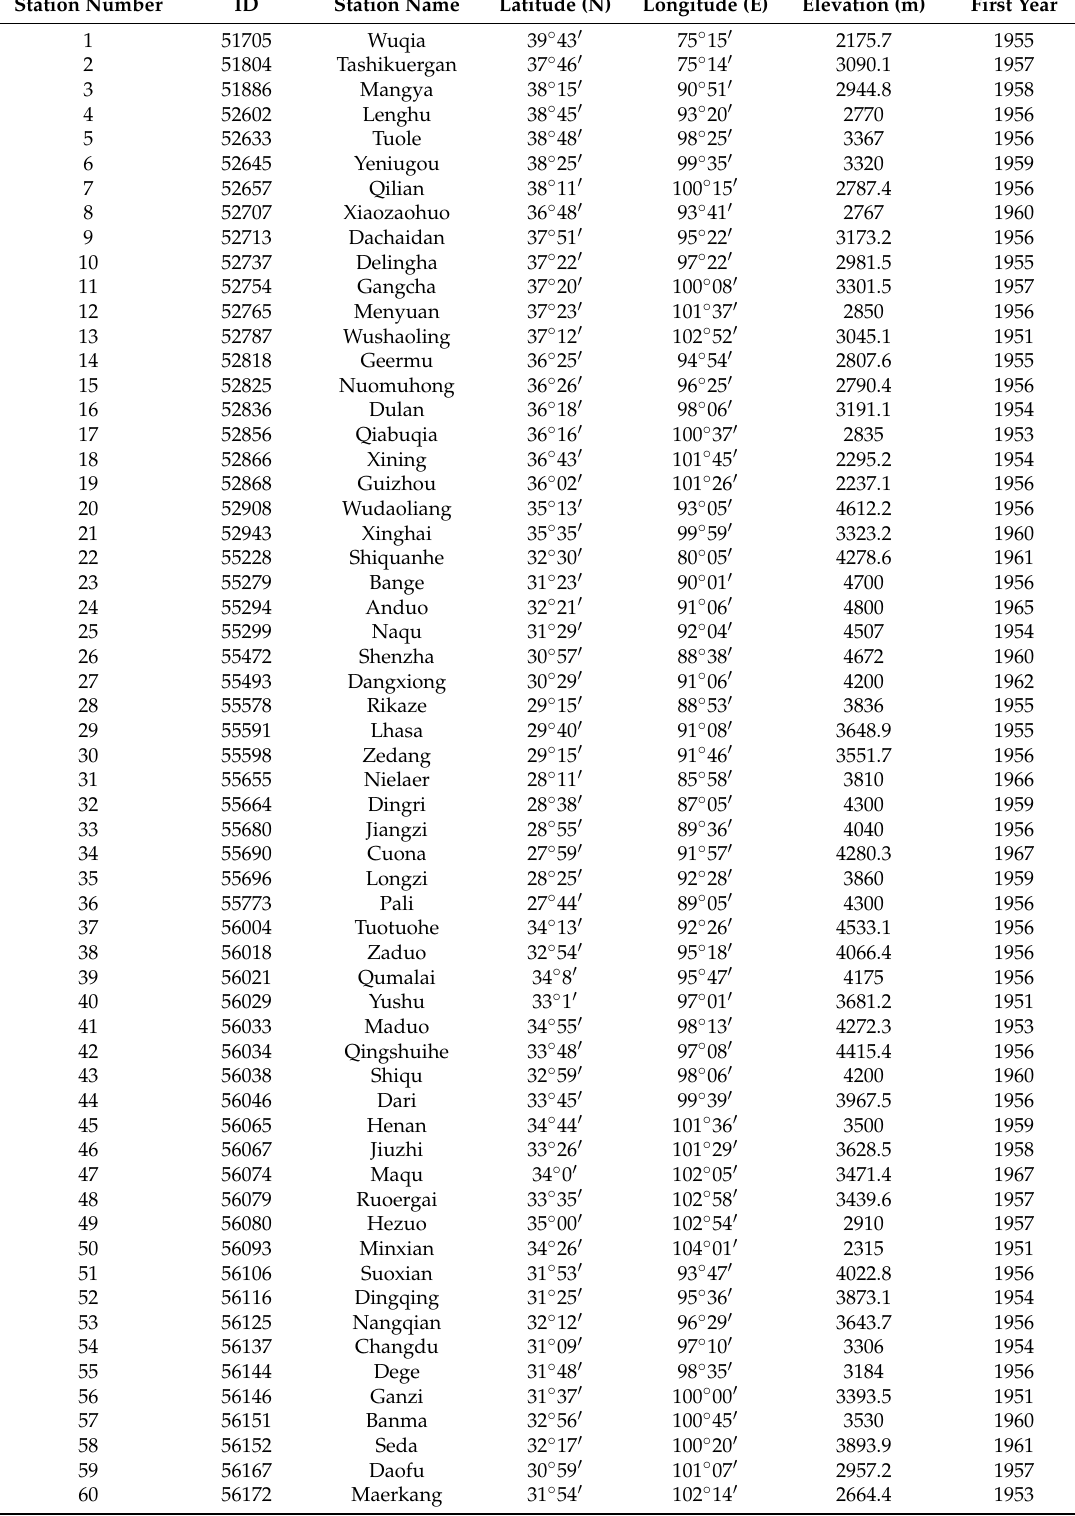
Table A1. Detailed information of the selected